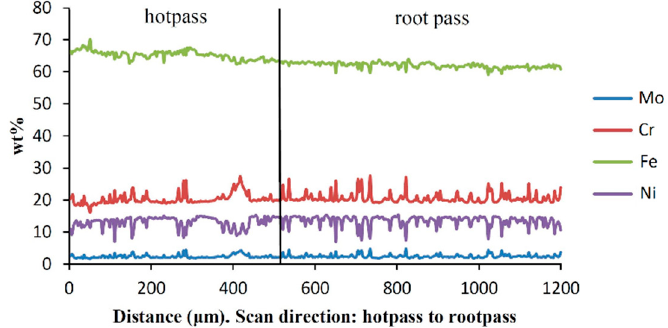
Figure 15. Electron probe microanalyzer (EPMA) quantitative analysis of X60 steel pipe with AISI 309 SS filler wire [19] .